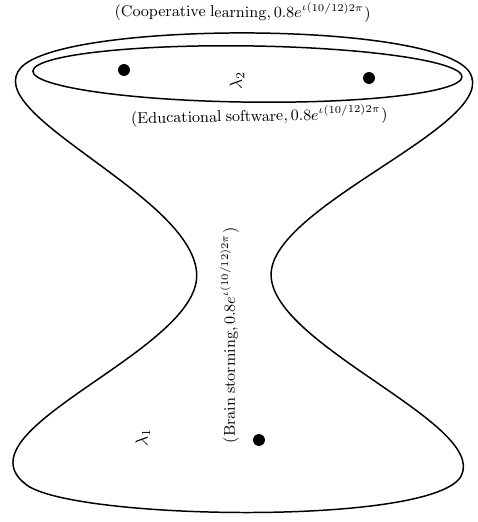
Figure 11. Complex fuzzy hypergraph model of teaching techniques.